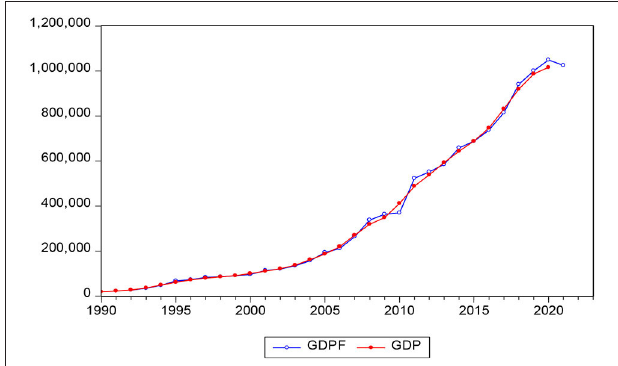
FIGURE 5 | Fitting graph of Chinese GDP forecast value and actual value from 1990 to